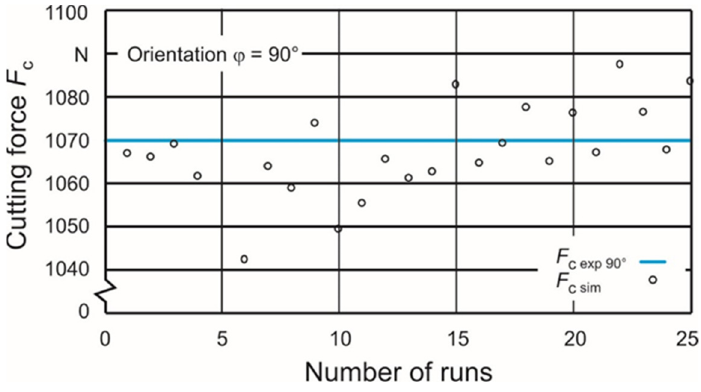
Figure 7. Second iteration with 25 runs for orientation φ = 90°. Table 6. Resulting Johnson–Cook Parameters A, B, and n After the Second Identification Iteration.